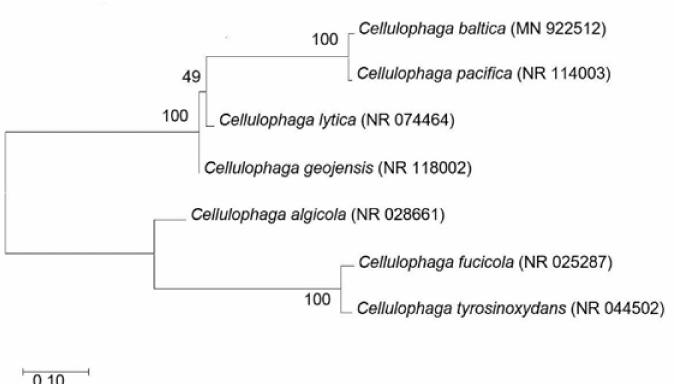
Figure 1. Phylogenetic analysis of the major Cellulophaga species. The phylogenetic tree was con- structed using MEGA 4.0 software via the neighbor-joining method based on 16S rRNA gene se- quences. The sequences were aligned using ClustalX. Numbers after the strain names refer to GenBank accession numbers of 16S rRNA sequences.